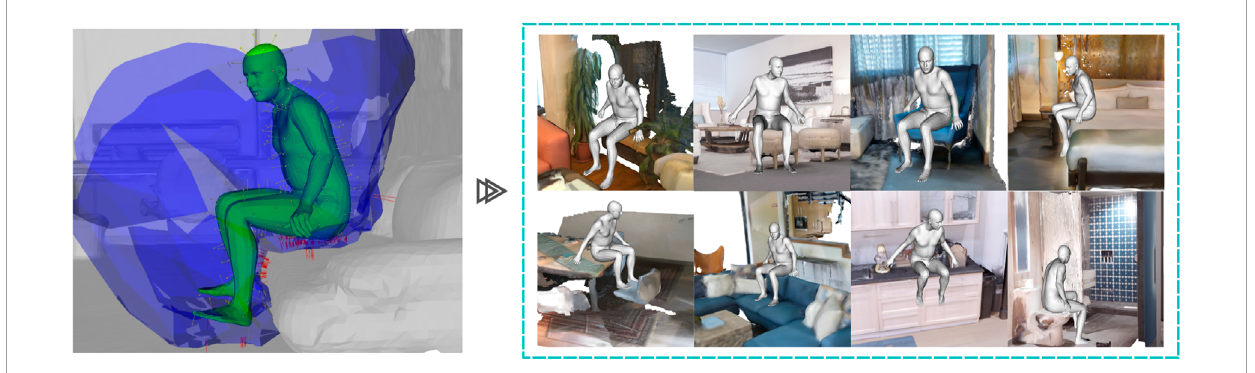
FIGURE 4 Our one-shot learning approach generalizes well on affordance detection. Only one example of an interaction is used to generate an AROS descriptor that generalizes well for the detection of affordances over previously unseen environments.